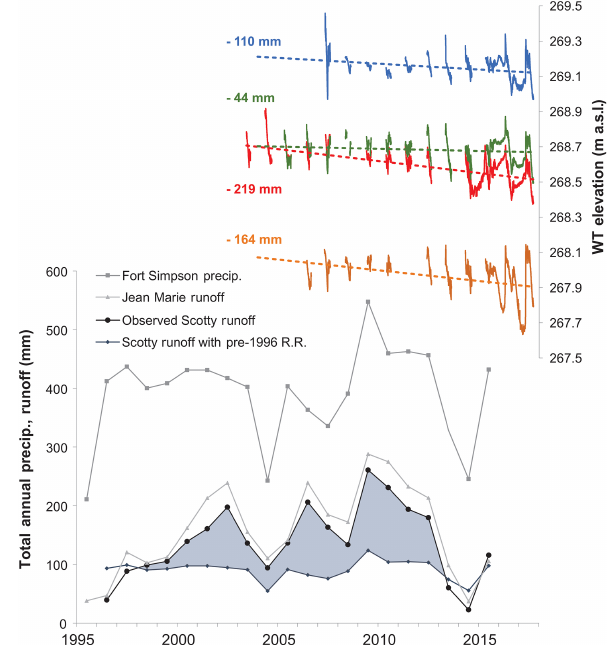
Figure 8. Water loss from four connected wetlands at Scotty Creek for the overlapping period of the runoff and water level records (coloured lines). Values (in mm) adjacent to each water level record represent the change in mean water level over the period of record. Total annual runoff measured at the Scotty Creek basin outlet and total annual precipitation (rain and snow) measured at Fort Simp- son for 1996 to 2015. Shaded area denotes extra observed runoff beyond that expected based on the mean of runoff ratios (RR) prior to 1996 and the quantity of precipitation. Runoff from the neigh- bouring Jean Marie River is plotted to illustrate the similar timing and magnitude of elevated basin runoff. All runoff amounts are to- talled over the water year (1 October–30 September). Adapted from Haynes et al.